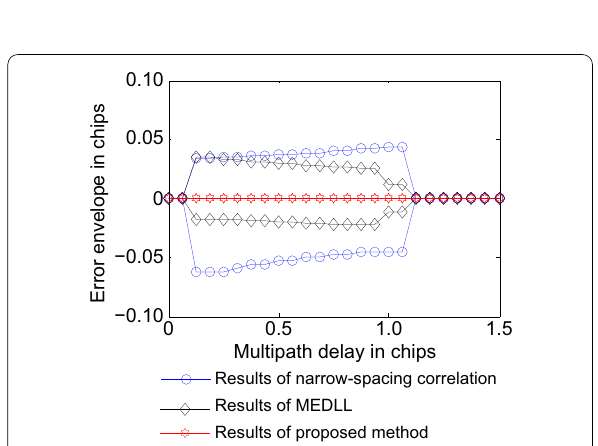
Fig. 6 Comparison of the error envelopes with σ s = 0.5 , in the condition of only one NLOS signal combined with the LOS signal and no consideration of the noise and